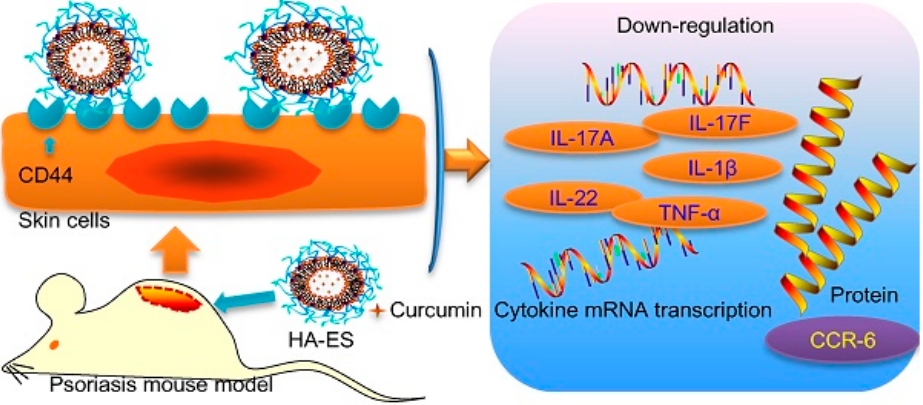
Figure 6. Schematic illustration of the curcumin-loaded HA-ES targeted CD44 protein and reduced the level of TNF- α , IL-17A, IL-17F mRNA, etc., and lowered the expression of CCR-6 protein [141]. Reproduced with permission from Yongtai Zhang, THERANOSTICS; published by Ivyspring Inter- national, 2019.